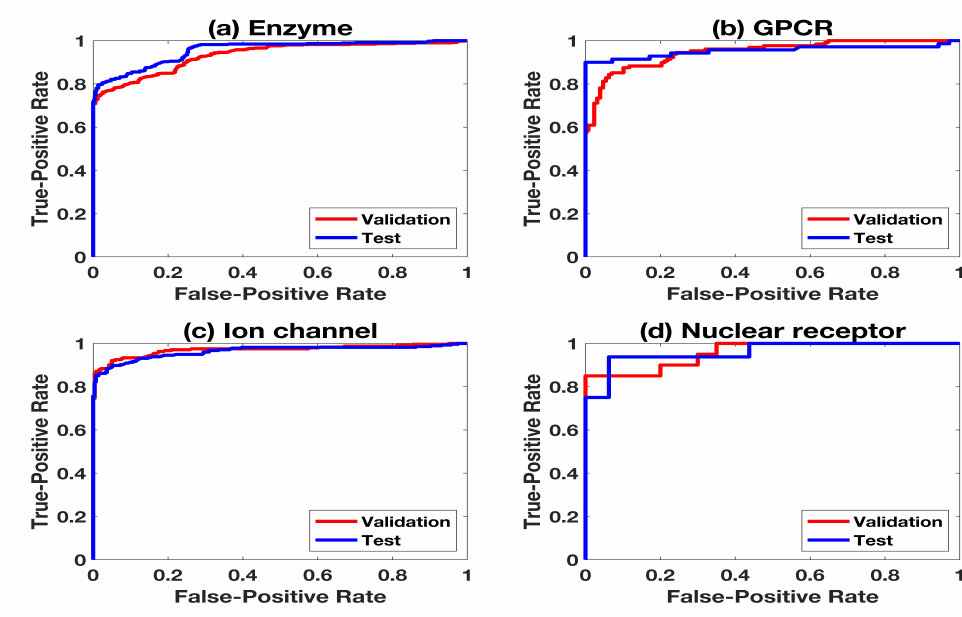
Figure 3. ROC-curves predicted on the validation set and the test set of each sub-dataset. The experi- ments are based on different drugs of the training set, validation set, and test